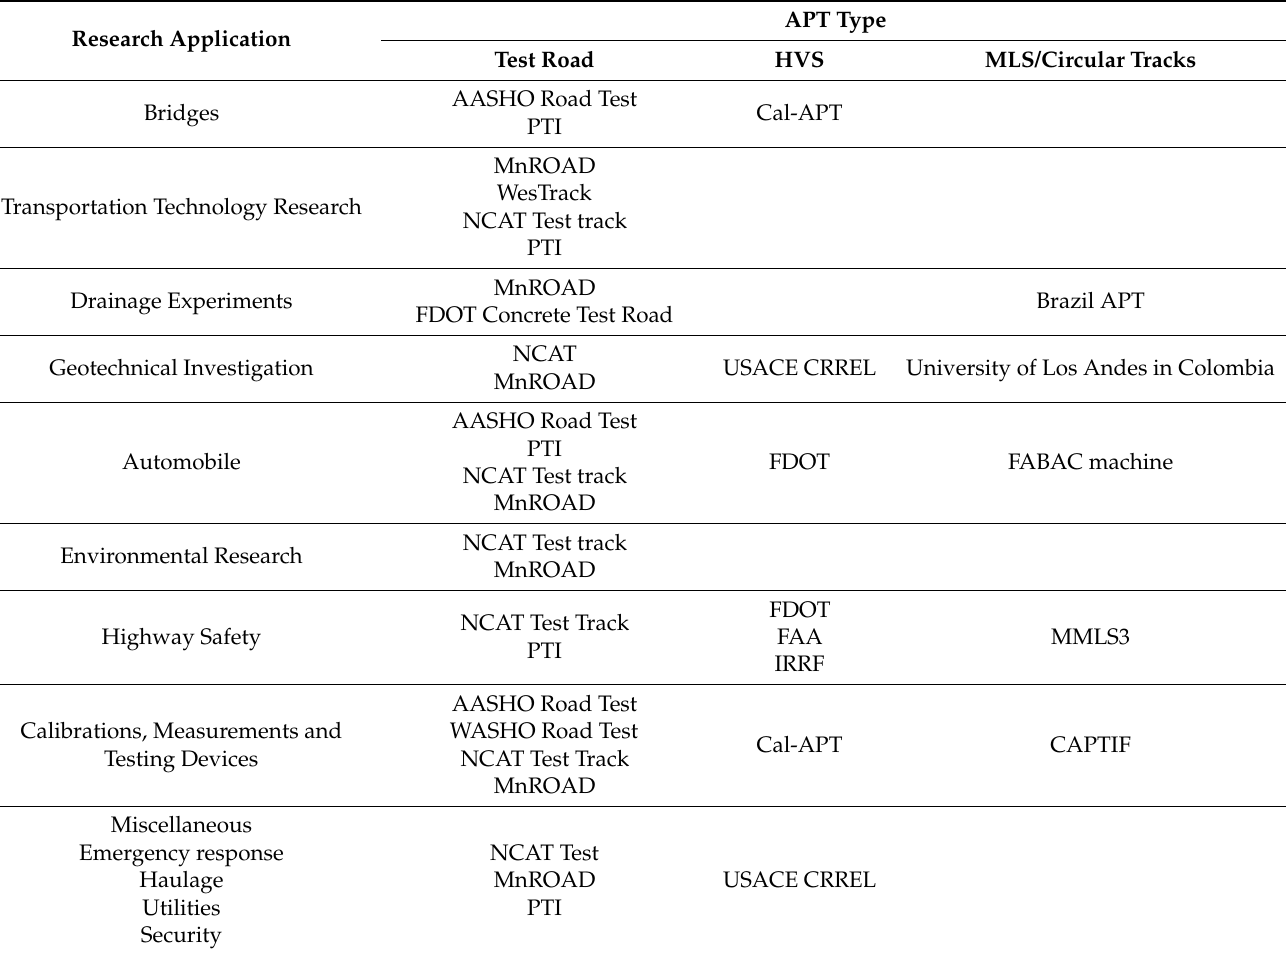
Table 1. Non-pavement applications with different APT types identified during the